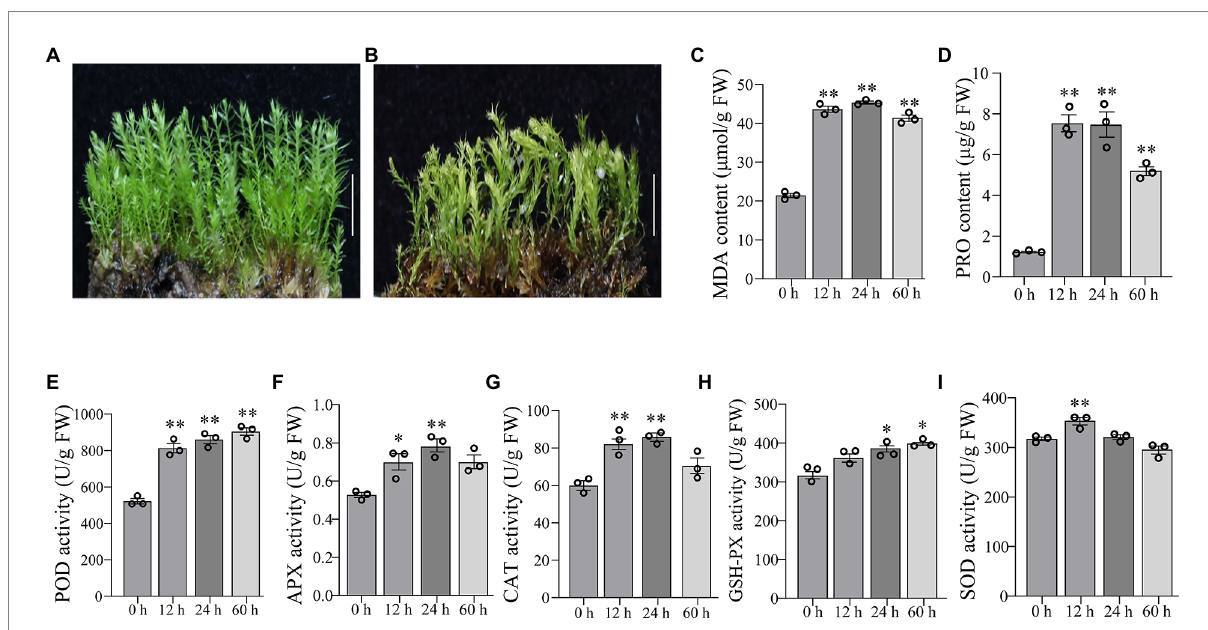
FIGURE 1 The moss Pohlia nutans can tolerance strong drought stress. (A) Photo of P. nutans cultured under normal condition. (B) Photo of P. nutans treated with PEG6000 for 60 h to simulate the drought stress. (C–I) The biochemical features of P. nutans under PEG6000 treatment. All experiments were repeated three times. Bar = 1.0 cm. Significant difference ( * p < 0.05, ** p <